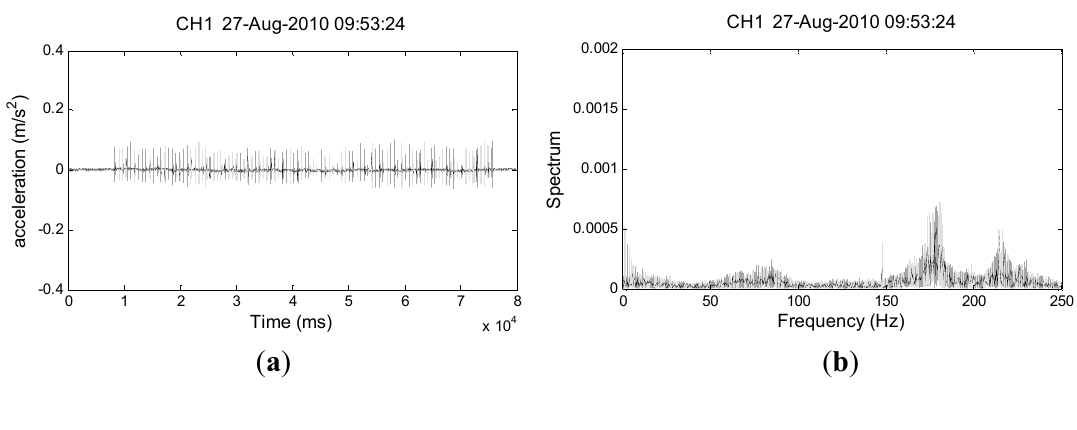
Figure 10. Testing signals measured by Sensor 1 in fiber-optic sensing system deployed along Ai-Yu-Zi Creek (AYZ-1 sensor, Figure 8); ( a ) time domain, ( b ) frequency domain, and ( c ) time-frequency domain obtained by Gabor